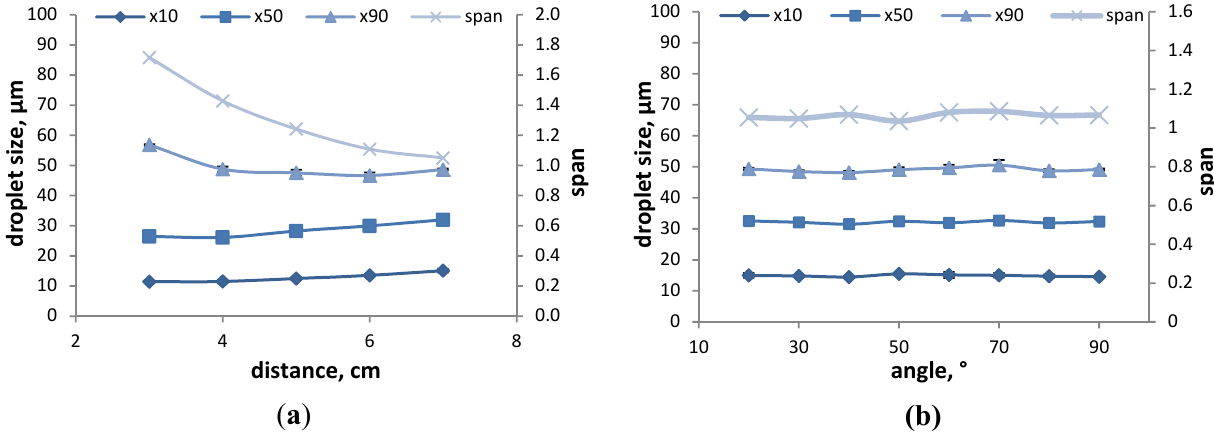
Figure 2. The effect of distance to the measuring zone ( a ) and spraying angle ( b ) on the DSD and span of the model formulation (water) measured at an actuation force of 60